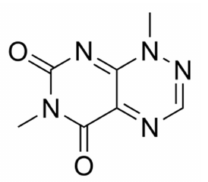
Figure 5. Chemical structure of